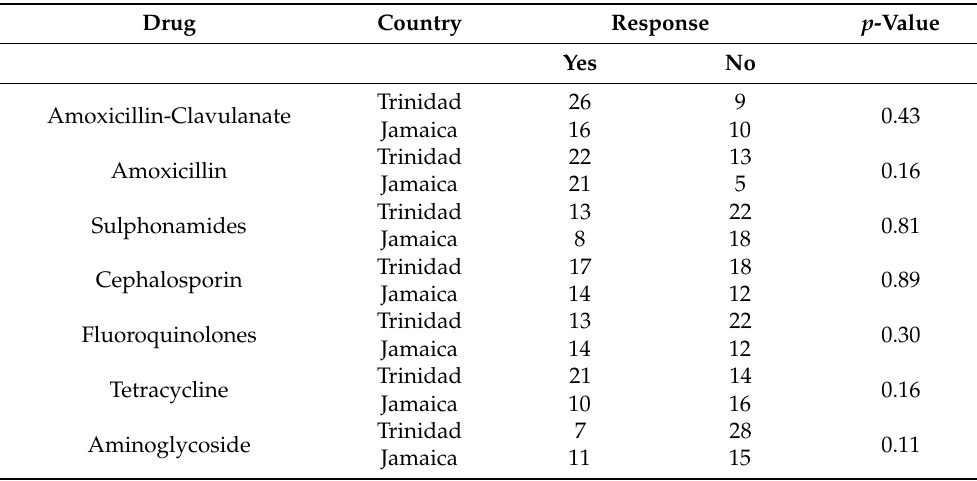
combinations compared to clinics in Jamaica ( p < 0.01)